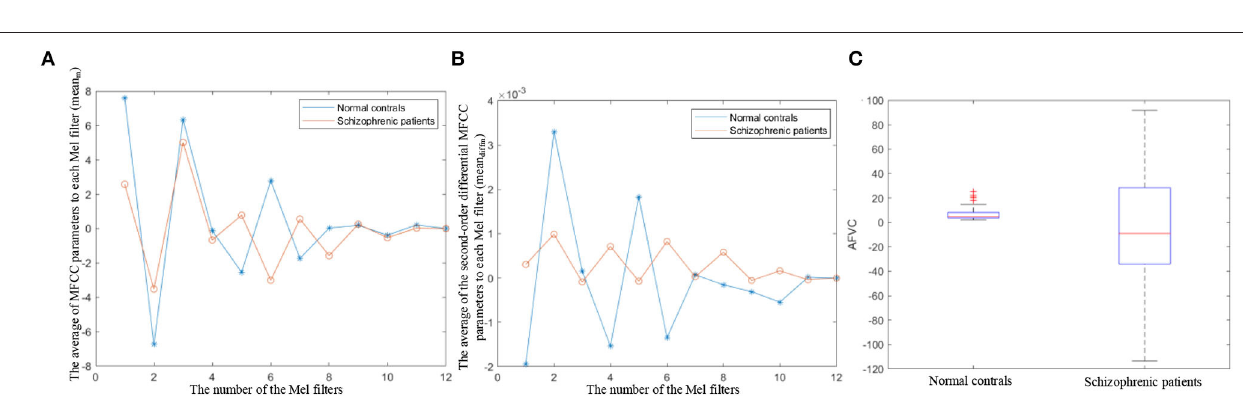
FIGURE 7 | (A) The distribution of the average of MFCC parameters to each mel filter. (B) The distribution of the average of the second-order differential MFCC parameters to each mel filter. (C) Boxplot of AFVC.